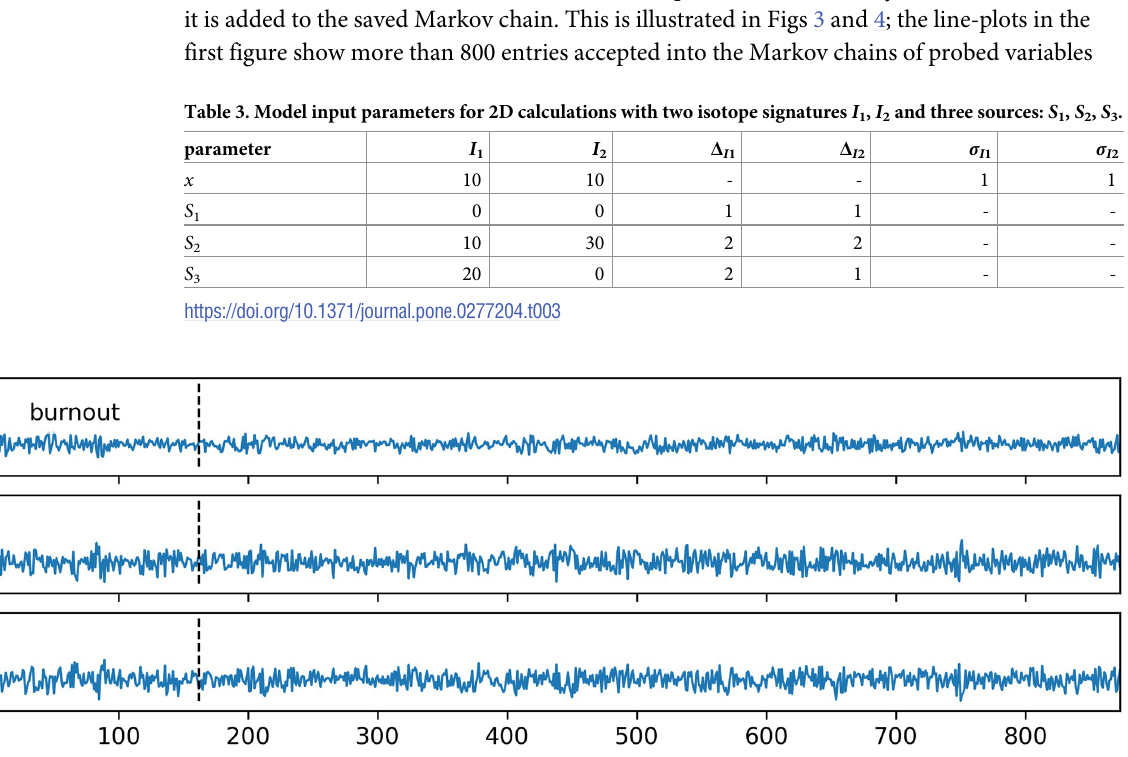
Fig 3. Mixing configurations ( f 1 , f 2 , f 3 ) from all model iterations that fulfilled the Metropolis condition—The Markov chain. The number of initial iterations required for the model stabilisation is discarded (burnout, left to the dashed line), reaching the region of maximum likelihood. In MCMC simulations it is crucial that stabilization is indeed achieved, therefore such a plot is a key tool for quality assessment. In this example, the simulation begins with fractions already close to the equilibrium value, thus the stabilization is achieved virtually instantly and no visible change in oscillations is observed in dependence on the iteration